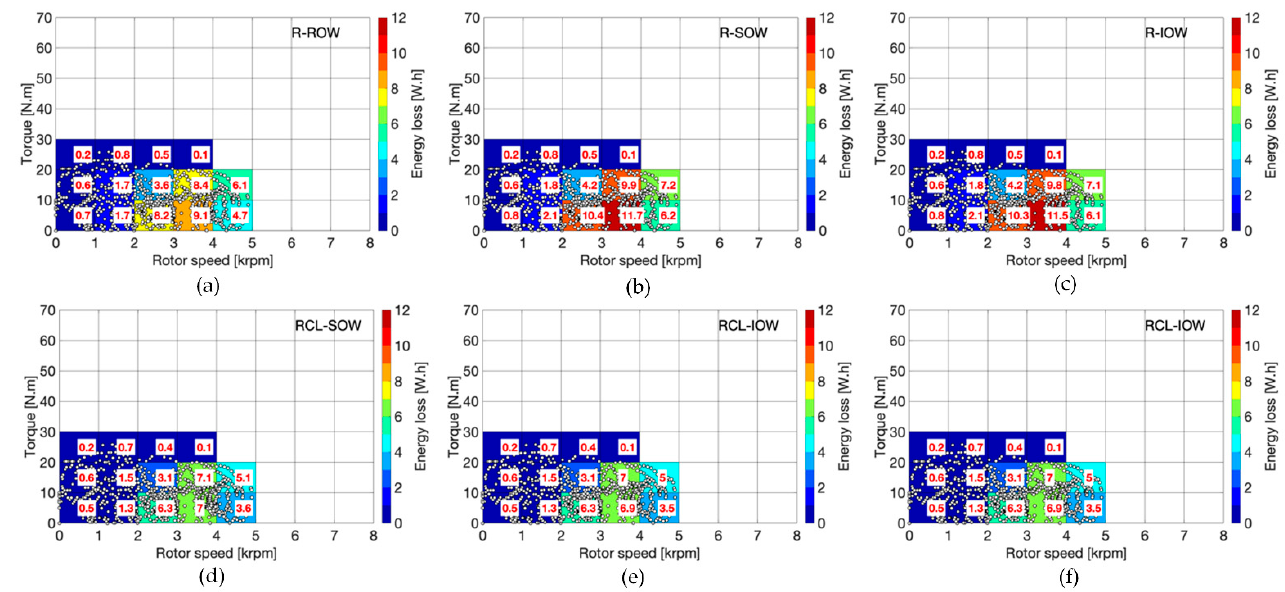
Figure 11. Energy loss distributions of the IPMSM with ( a ) R-ROW, ( b ) R-SOW, ( c ) R-IOW, ( d ) RCL-SOW, ( e ) RCL-IOW, and ( f ) H-NOW arrangements, along the WLTP Class 2 driving cycle.